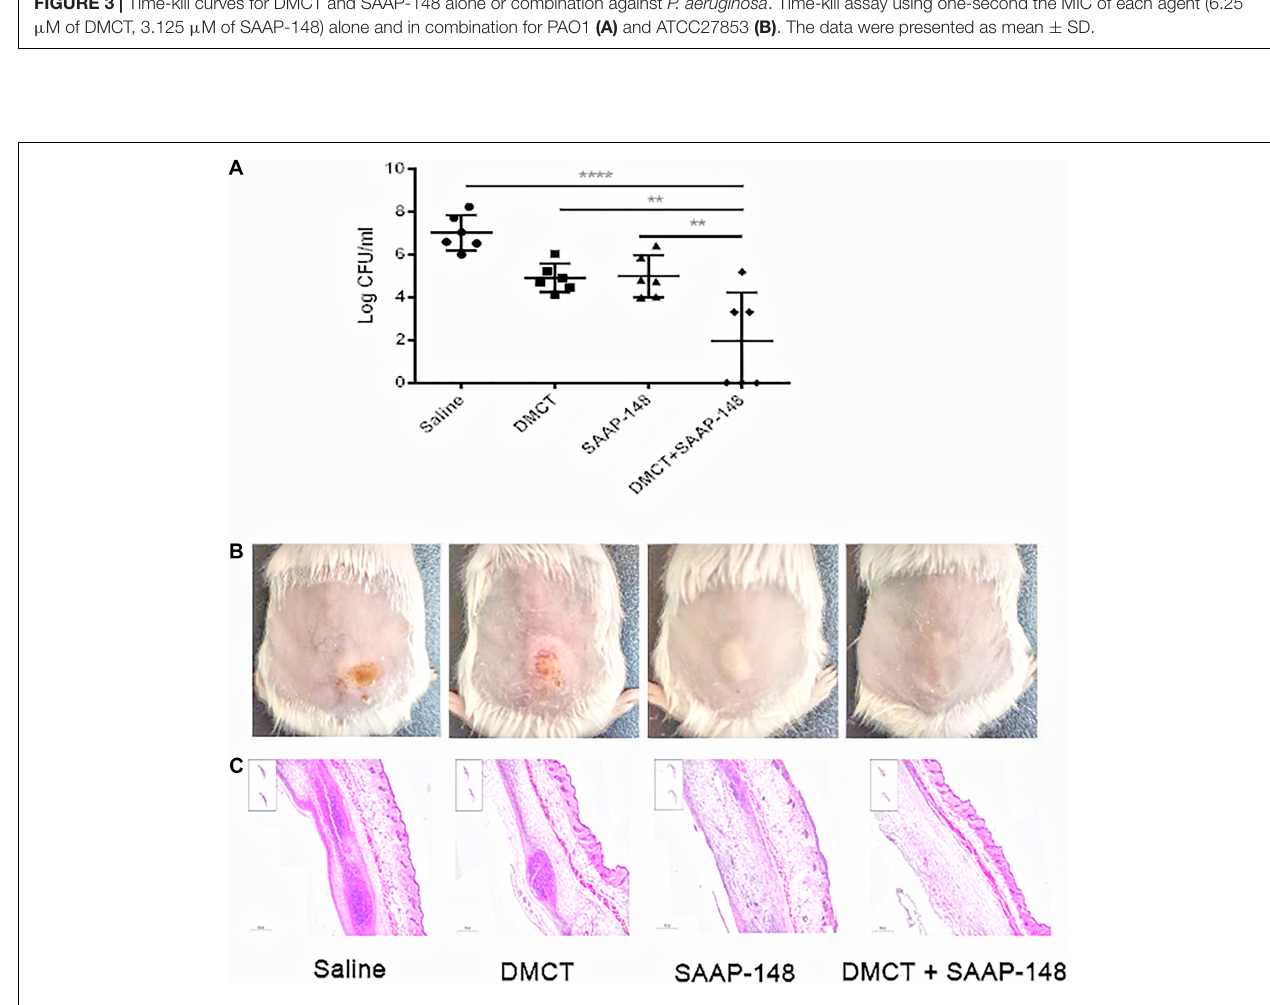
FIGURE 4 | DMCT and SAAP-148 combinatorial therapy in a murine cutaneous abscess model. CD-1 female mice were injected with 1 × 10 9 CFU/ml P. aeruginosa PAO1 and treated 1 h post-infection with saline (control), DMCT, SAAP-148, or DMCT + SAAP-148 combination. Drugs concentrations for all conditions were as follows: DMCT, 5 mg/kg and SAAP-148, 10 mg/kg. Infected abscess lumps and pus were excised to determine CFU by 3 days post-infection. Counted CFU/ml data is expressed (A) . An entire dorsal back abscess and representative results are shown at 3 days after therapy for PAO1 (B) . (C) Histological results (H&E stain, 3 × , down panels) are shown at 3 days after therapy for mono- or combined therapy. All experiments were performed three times with 2–4 mice per group. Statistical analysis was performed using one-way ANOVA, Kruskal–Wallis test with Dunn’s correction (two-sided). The asterisk indicates significant differences. ** P < 0.01; **** P <